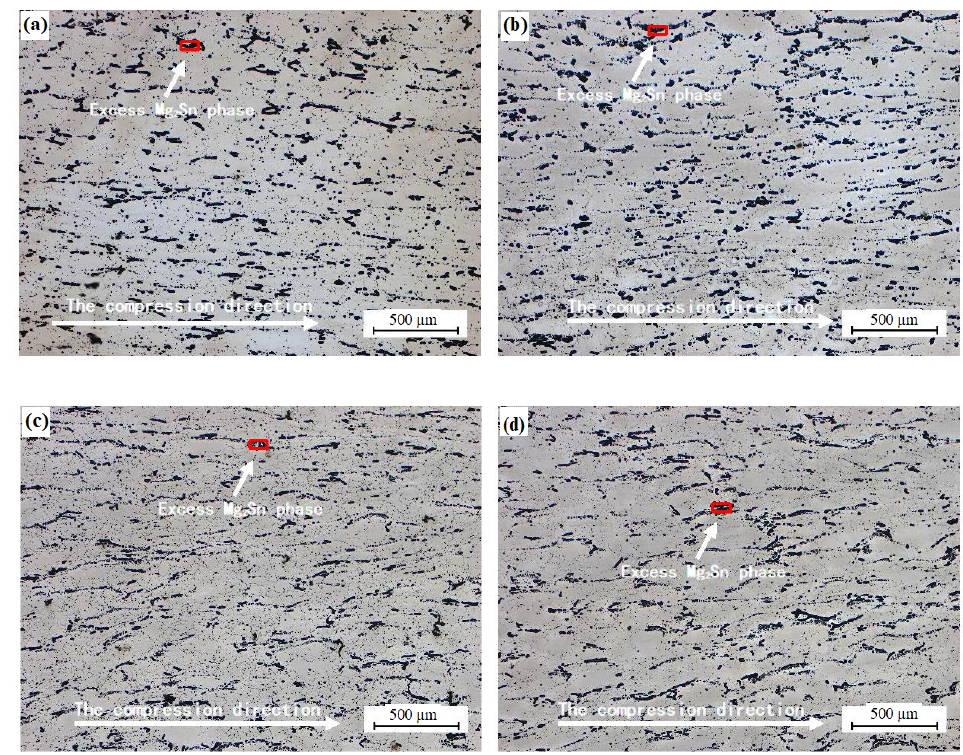
Figure 8. Microstructures of the alloy during hot compression at the temperature of 733 K. ( a ) 0.001 s − 1 ; ( b ) 0.01 s − 1 ; ( c ) 0.1 s − 1 ; ( d ) 1 s − 1 .